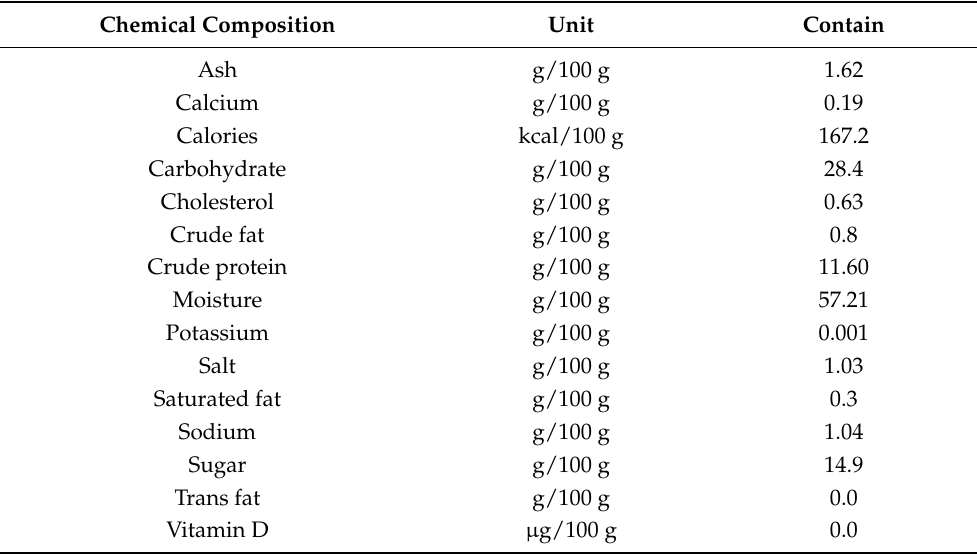
Table 7. Nutritional values of test seafood HMR products consisting of a mixture of AMPS, CSM, and